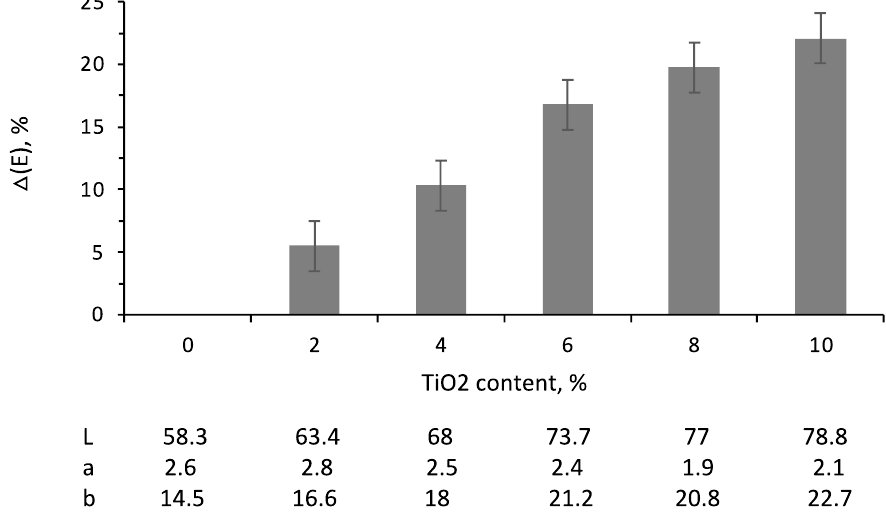
Figure 5. Effect of TiO 2 additions on colorimetry measurements.